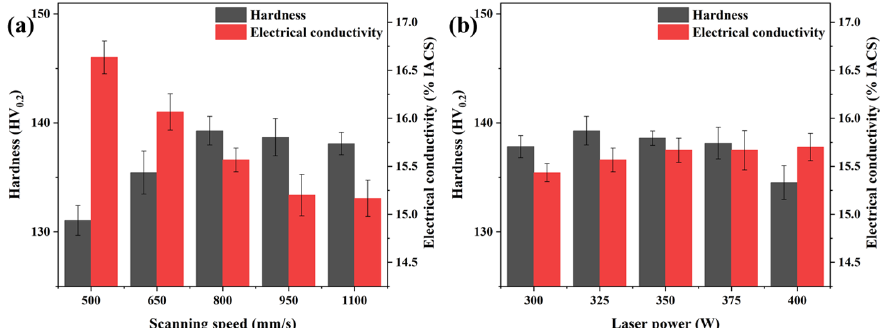
Figure 16. Effect of scanning speed (laser power of 325 W) ( a ) and laser power (scanning speed of 800 mm/s) on ( b ) the microhardness and electrical conductivity of as-built Cu–Cr–Nb–Ti alloy sam- ples.